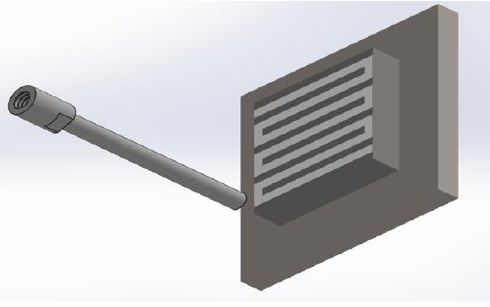
Figure 2. Trajectory of the spray gun.